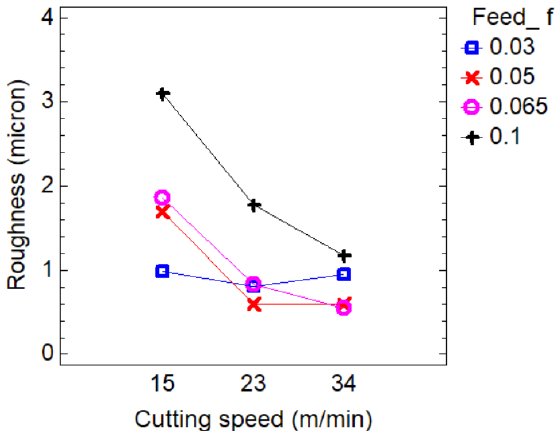
Figure 4. Interaction plot of the combined influence of the cutting speed and feed on the surface roughness.